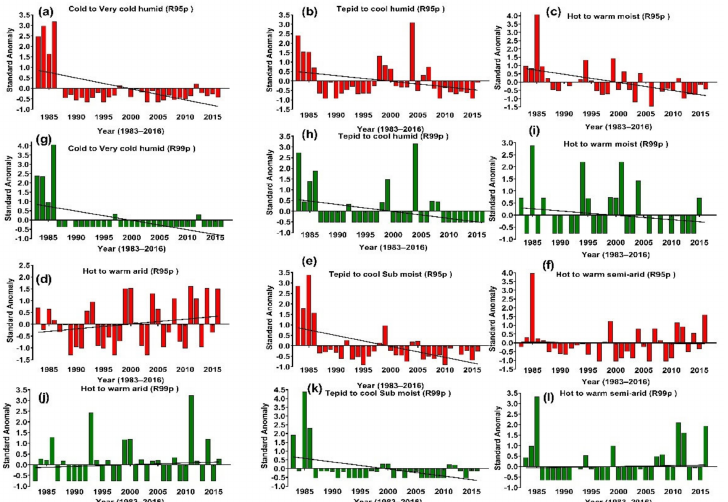
Figure 12. Very wet days (R95p) ( a – f ) and extremely wet days (R99p) ( g – l ) over agroecological zones for the period